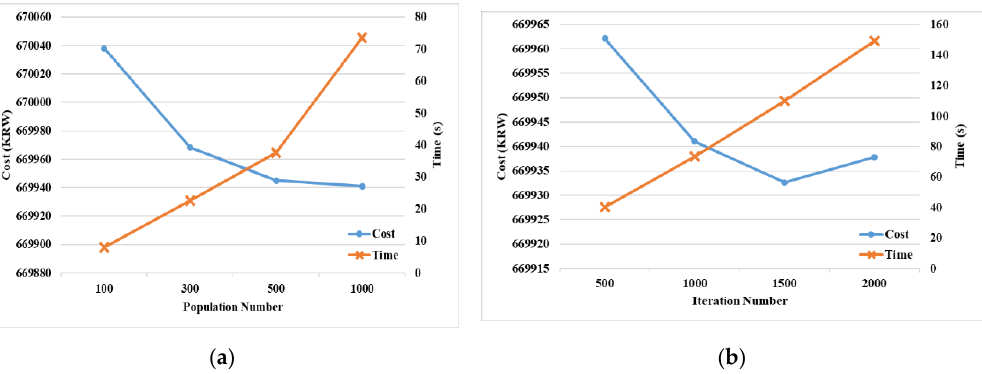
Figure 8. Simulation results for Case 1 by changing the population number N p and the iteration number N : ( a ) Fix N = 1000; and, ( b ) Fix N p = 1000.